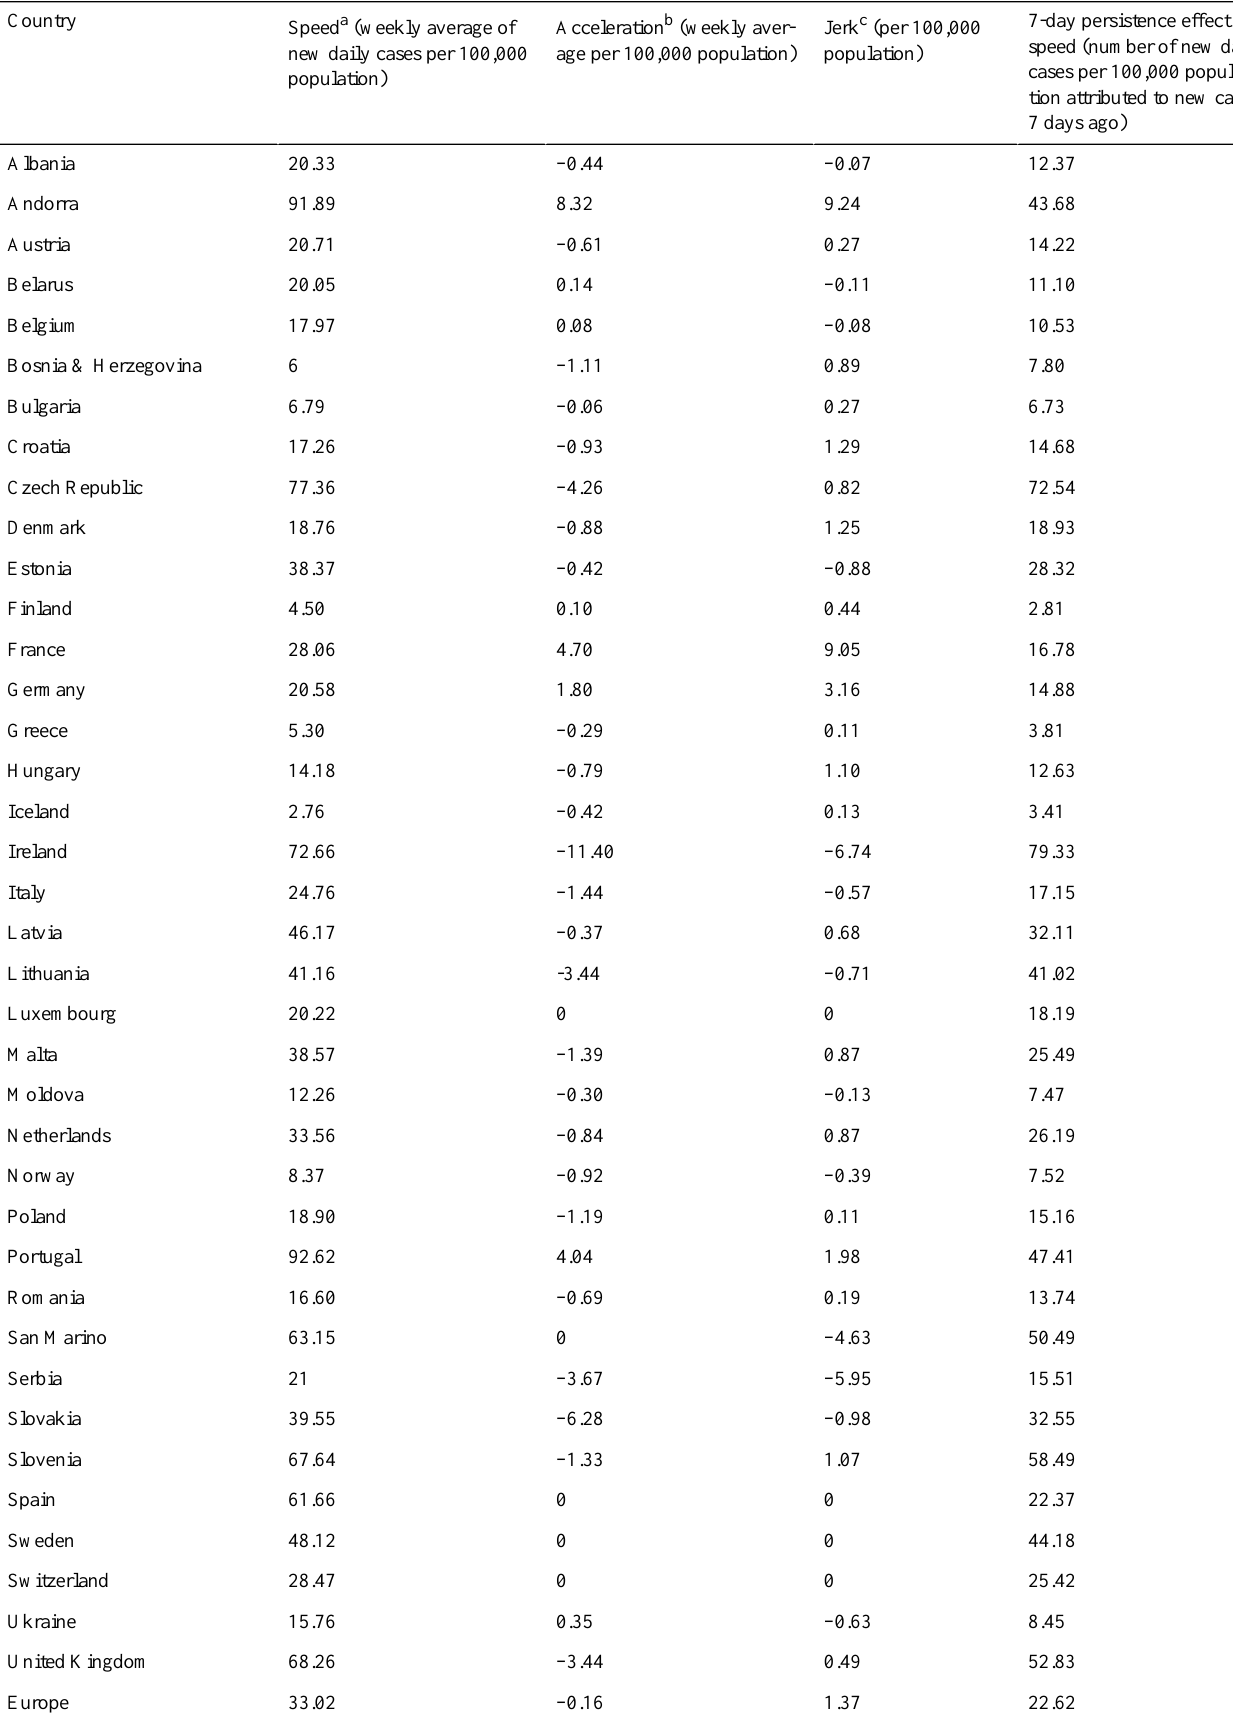
Table 5. Novel surveillance metrics for the week of January 11-17,